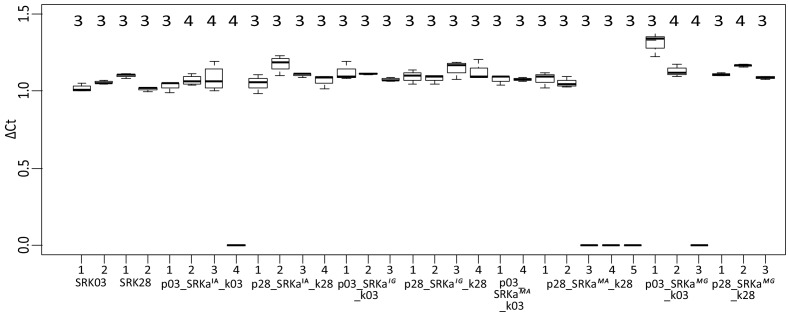
Transgene expression analysis of the different SRK-transformed lines.ΔCt (Cycle threshold) was calculated as the ratio of Ct-SRK on Ct-Ubiquitin. The number of biological replicates is indicated above each boxplot. For each biological replicate, measurements were realized in technical triplicates.